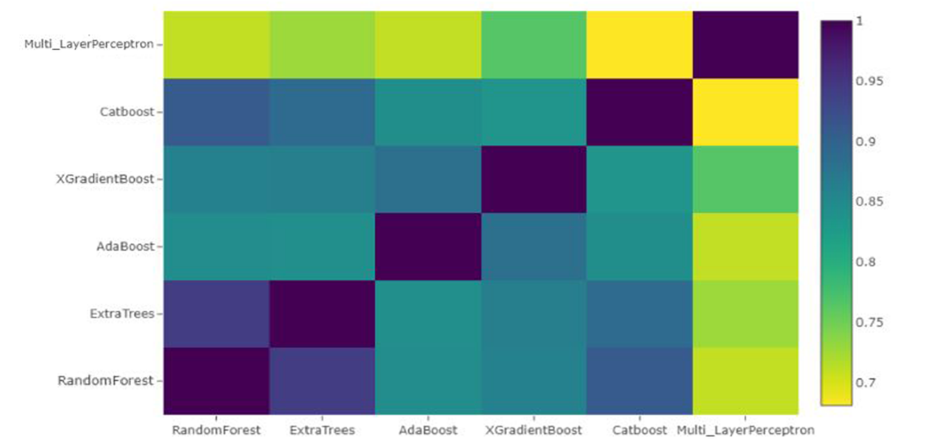
Figure 4. Pearson Correlation between features after stacking.